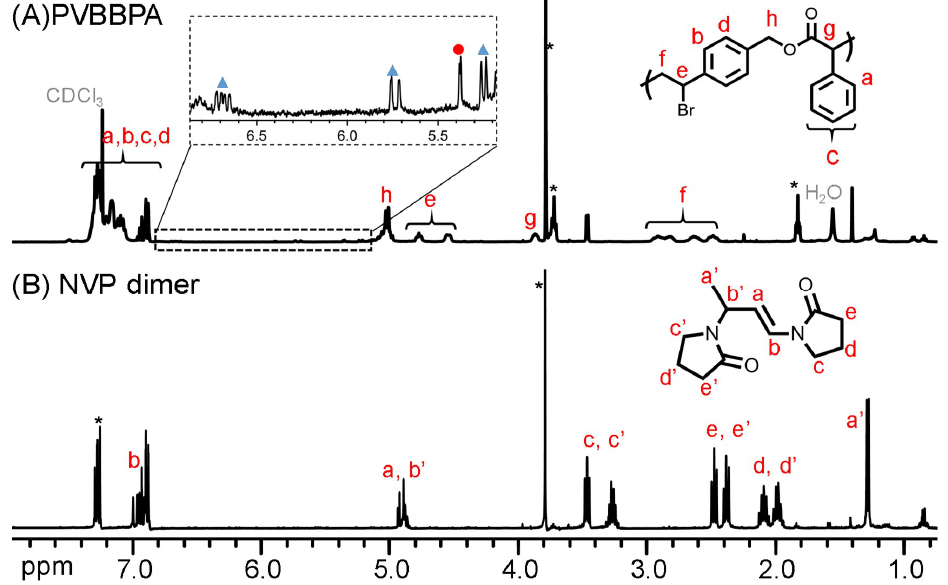
Figure 2. 1 H NMR spectra of ( A ) PVBBPA and ( B ) NVP dimer (* represents solvent peaks of anisole).